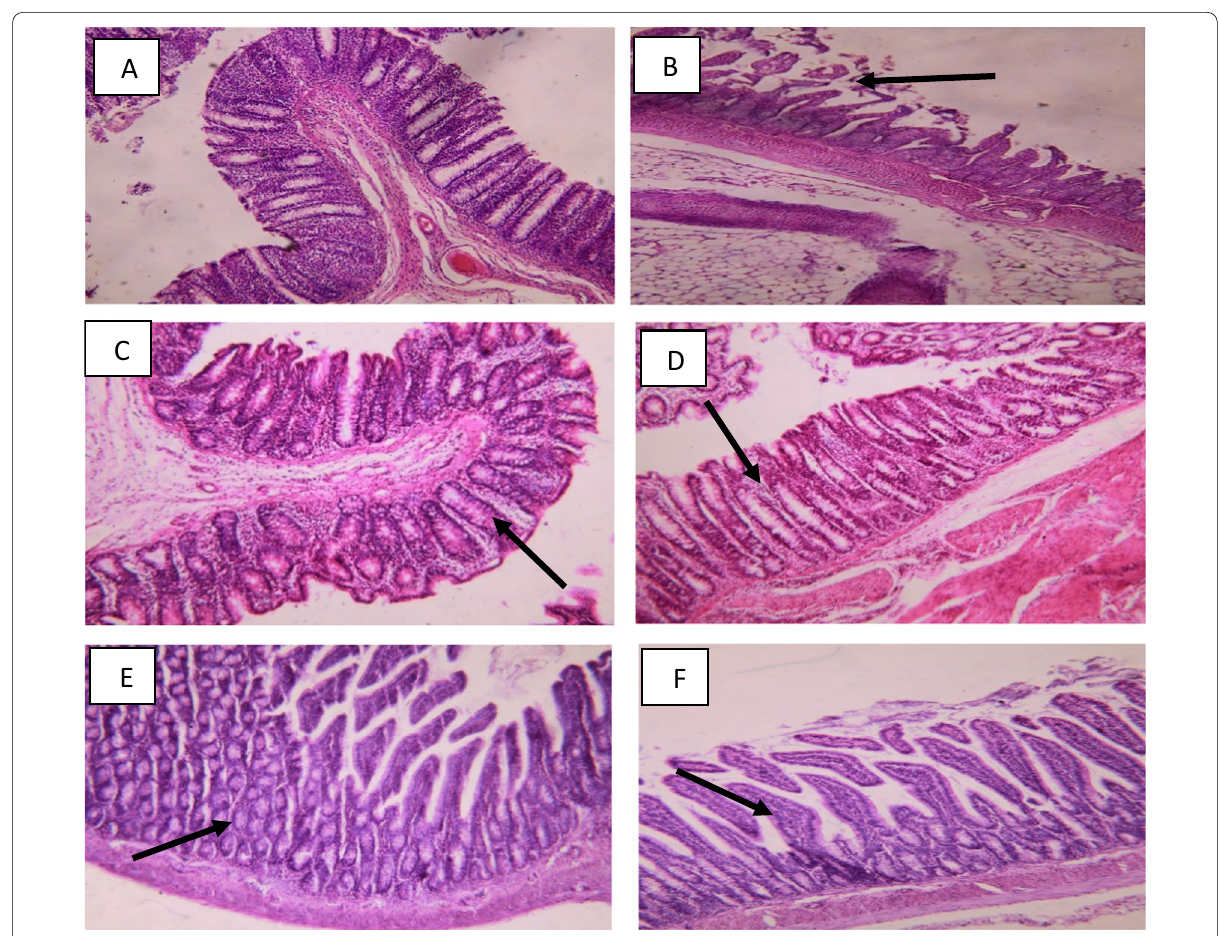
Fig. 2 Sections of intestine of all groups ( 400, H&E): A Control group: Normal appearance of intestinal crypts, villi and goblet cells; B CKD group: × Atrophy and shedding of the vill ͢ i; C Early probiotic CKD: normal crypts ( ) lined by goblet cells and columnar absorptive cells; D Late probiotic CKD: ↑ normal crypts ( ) lined by goblet cells and columnar absorptive cells; E Early symbiotic CKD and F late symbiotic CKD: normal crypts ( ↑ goblet cells and columnar absorptive